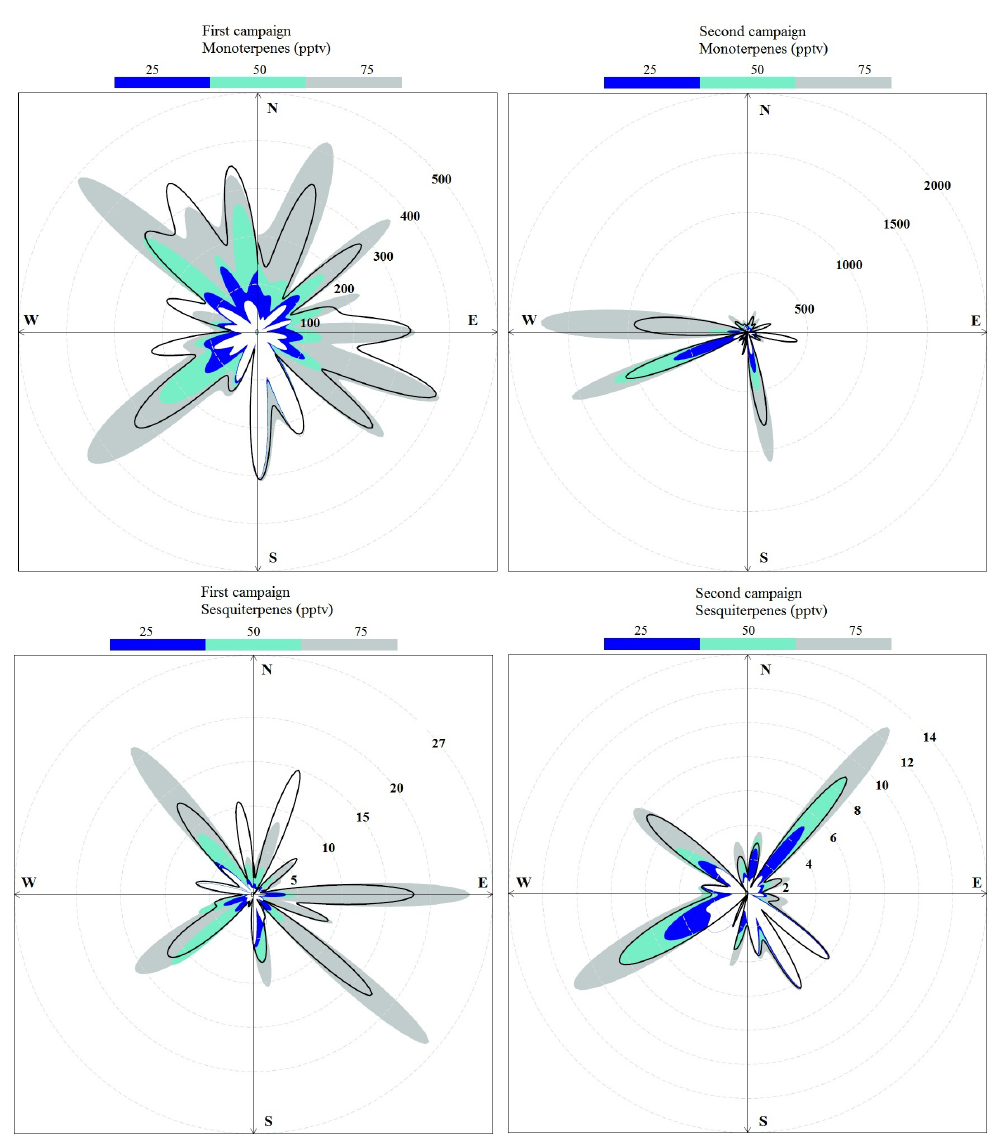
Figure 6. BVOC concentration rose at Welgegund for the two sampling campaigns. Different colours represent percentiles: blue – 25%, aquamarine – 50%, azure – 75%, and the black solid line represents the